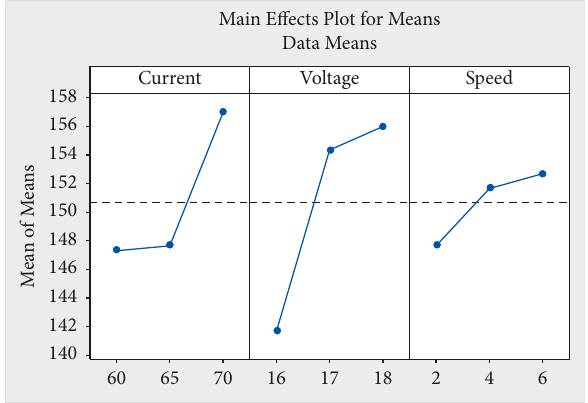
Figure 6: Main effects plot for means of welded zone.